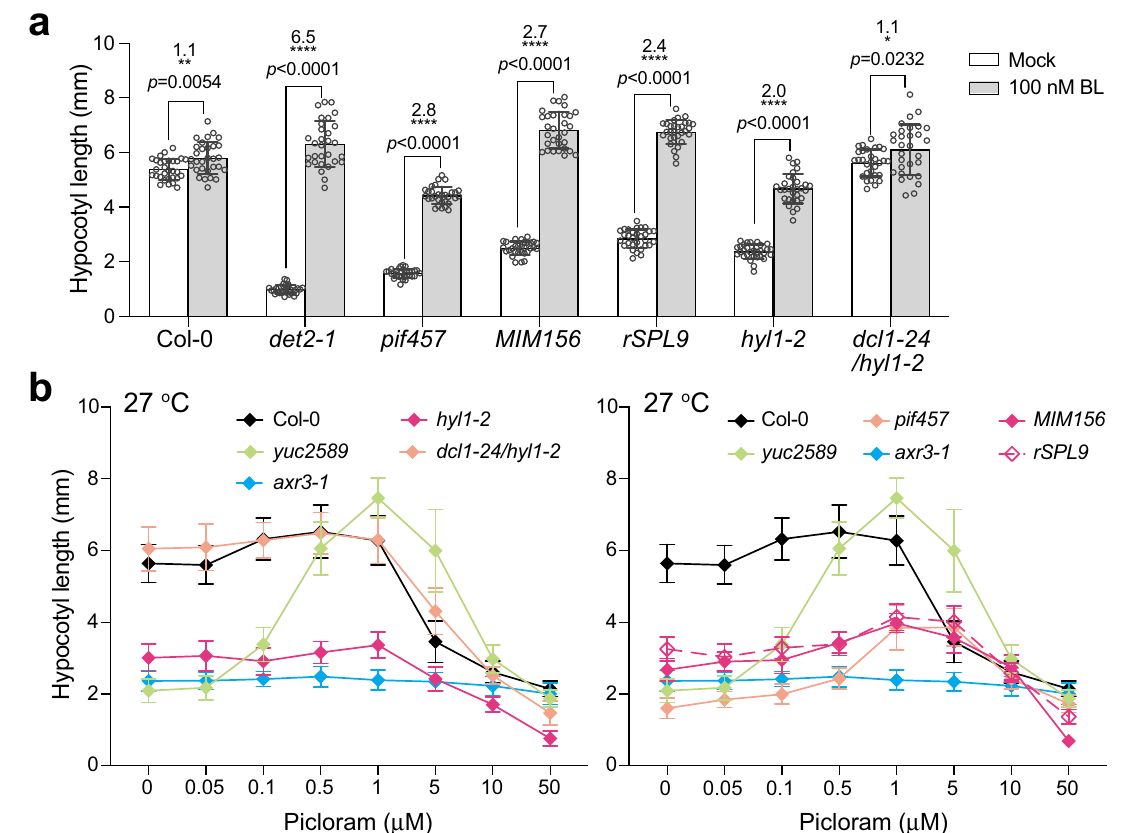
Fig. 5 | Perturbation of miR156/ SPL9 impedes auxin responsiveness at warm temperatures. a miR156/SPL 9 acts upstream of brassinosteroid biosynthesis in thermomorphogenesis. Hypocotyl length measurements of 4-d-old Col-0, det2-1 , pif457 , MIM156 , rSPL9 , hyl1-2 ,and dcl1-24/hyl1-2 grownunder50 μ molm − 2 s − 1 Rlight at27°Cwithorwithout100nMbrassinolide(BL).Errorbarsrepresentthes.d.ofat least30seedlings.Thecentersoftheerrorbarsindicatethemean.Thefoldchanges andthe p valuesbetweenthetreatedandmockcontrolseedlingsforeachgenotype areshownabovethecolumns.Statisticalsigni fi cancewasanalyzedusingtwo-tailed